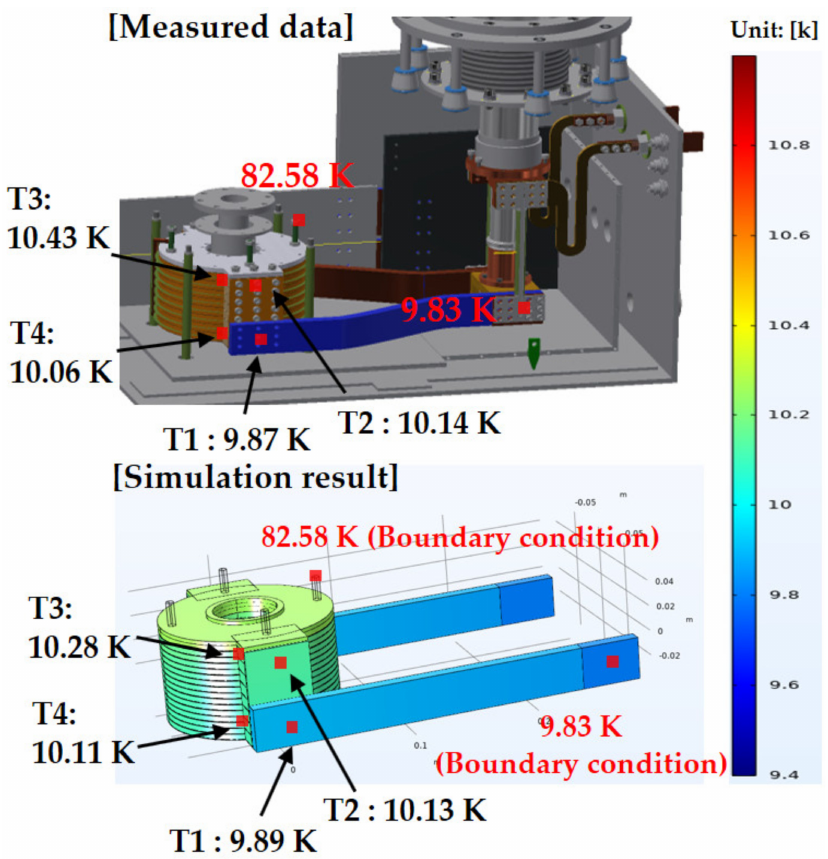
Figure 12. FEM simulation result of the 3 T